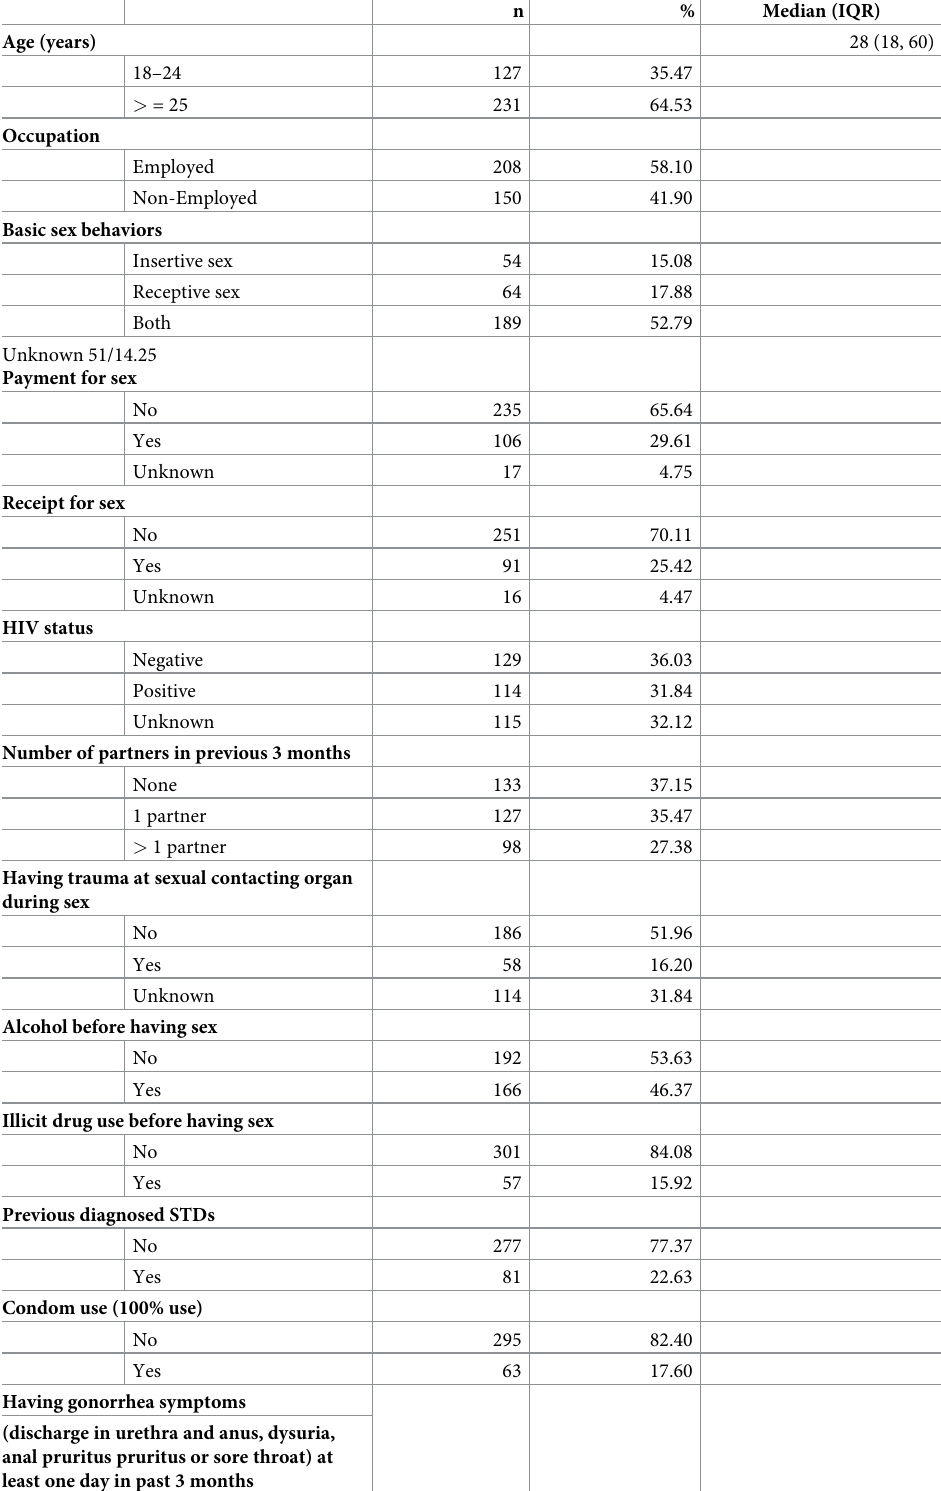
Table 1. Participants characteristics, N =